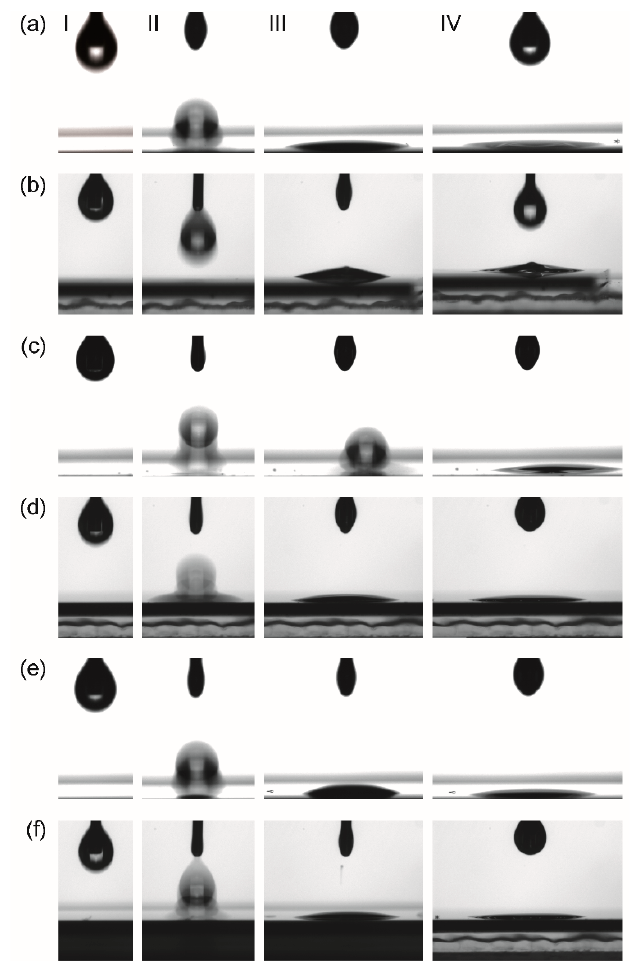
Figure 5. Images of characteristic stages (I–IV) of the contact angle measurements extracted from the movie clips recorded from the Drop Shape Analyzer instrument. I: start of experiment; II: impact of the droplet on the surface; III: situation after 1-2 s after impact. IV: just before impact of next droplet. ( a ) con -BZY and ( b ) µE -BZY on platinized silicon substrates; ( c ) con -BZY and ( d ) µE -BZY on fully BZY10 coated platinized silicon substrates; ( e ) con -BZY and ( f ) µE -BZY on oxidized silicon substrates. It should be noted that in the case of con -BZY droplet deposition onto BZY in ( c ), there is a slight movement of the droplet to the off-axis position. A possible reason for this could be an accidental impurity on the surface at the position of the droplet impact.